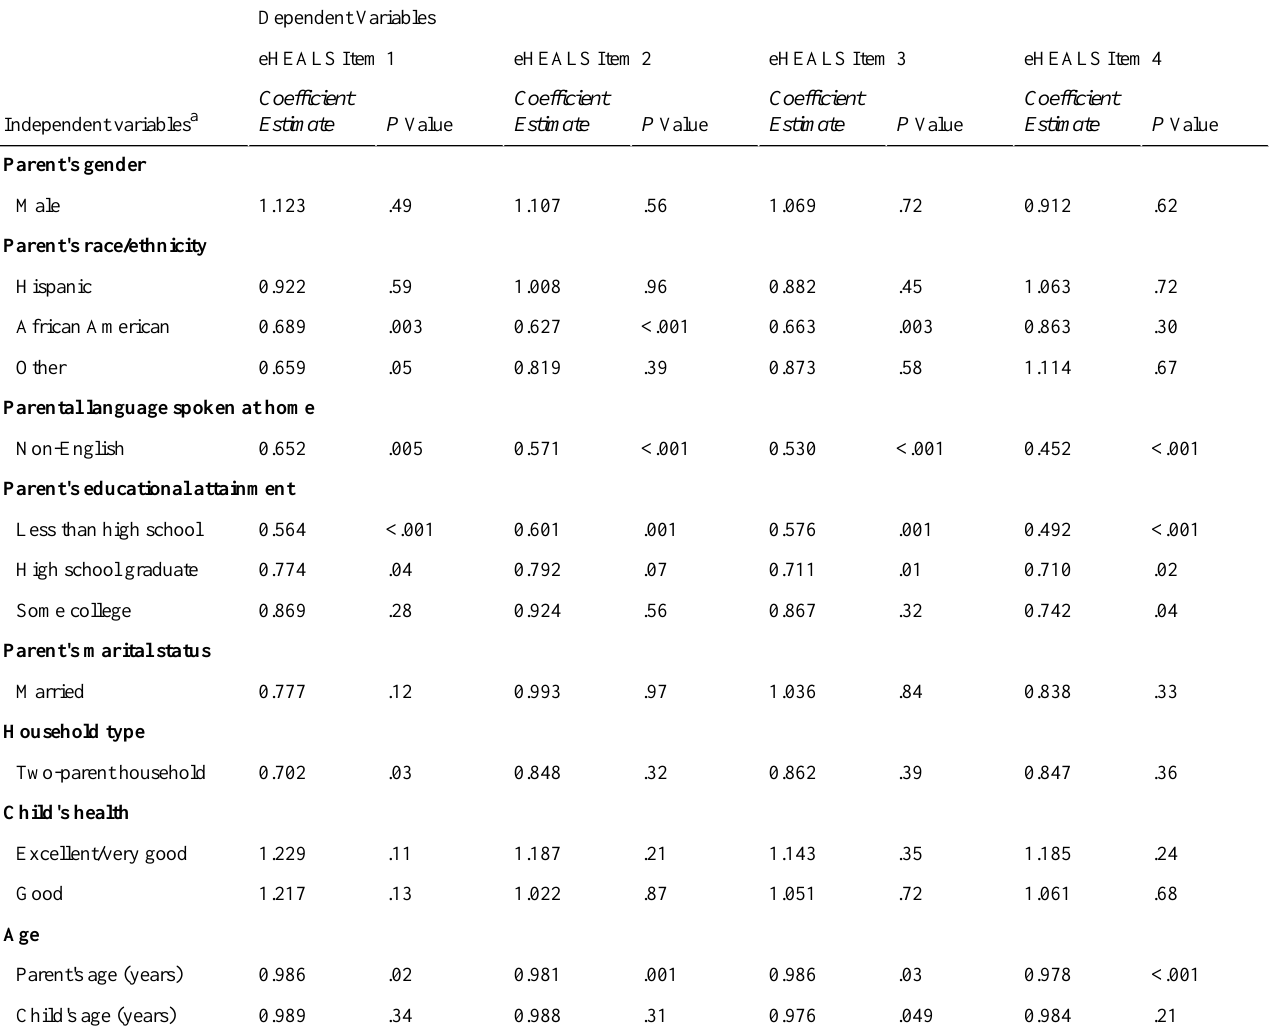
Table 5. Multivariate ordered logit regressions (eHEALs items 1 through 4) Dependent